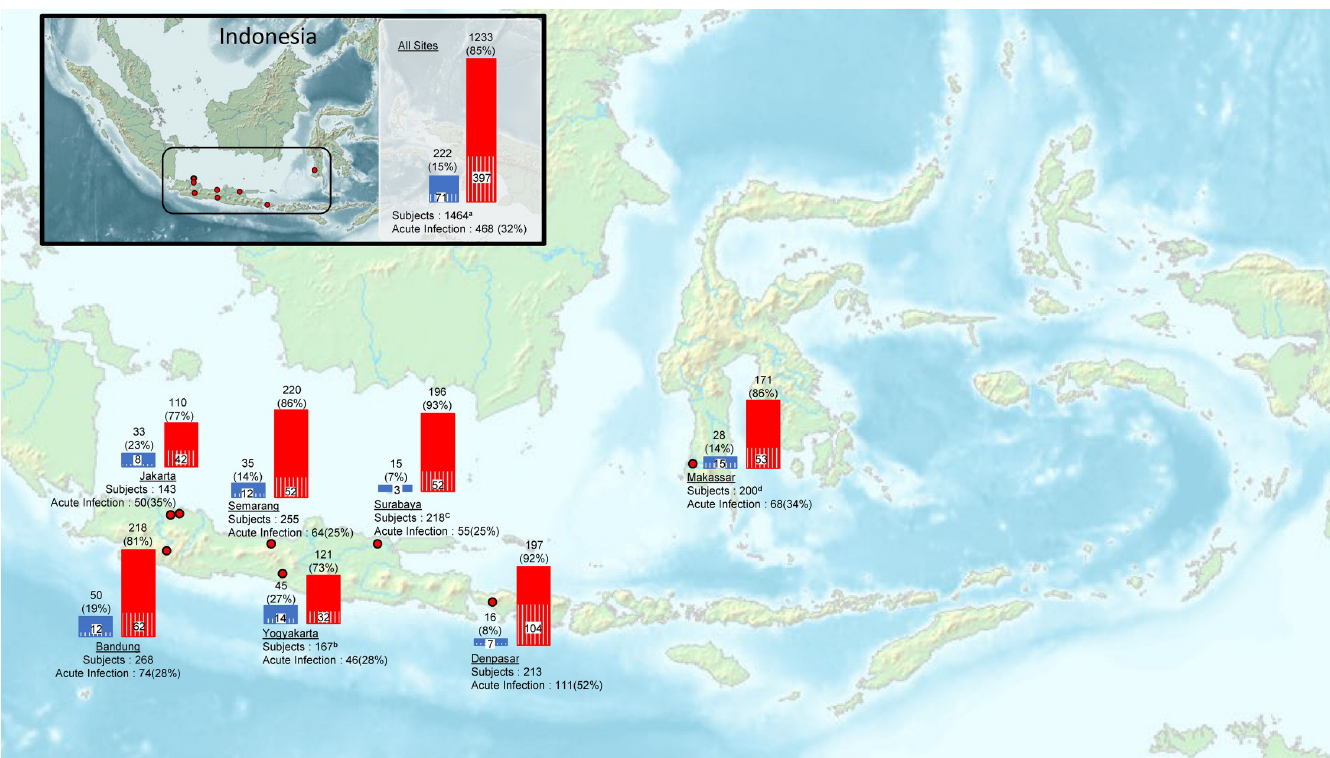
Fig 1. Geographic distribution and rates of DENV cases. Red dots show study site location. The number of fever cases and acute Dengue infections (percent) at each site are shown below the site name. Bars show the proportion of patients with (red bars) and without (blue bars) prior exposure; white stripes pattern inside the bars shows the subset who experienced acute infection. Note: Nine subjects a had no acute specimens for exposure prior to enrollment: 1 subject in Yogyakarta b , 7 subjects in Surabaya c , and 1 subject in Makassar d . Map source: Wikimedia Commons Atlas of the World [Atlas of Indonesia] . Available from: